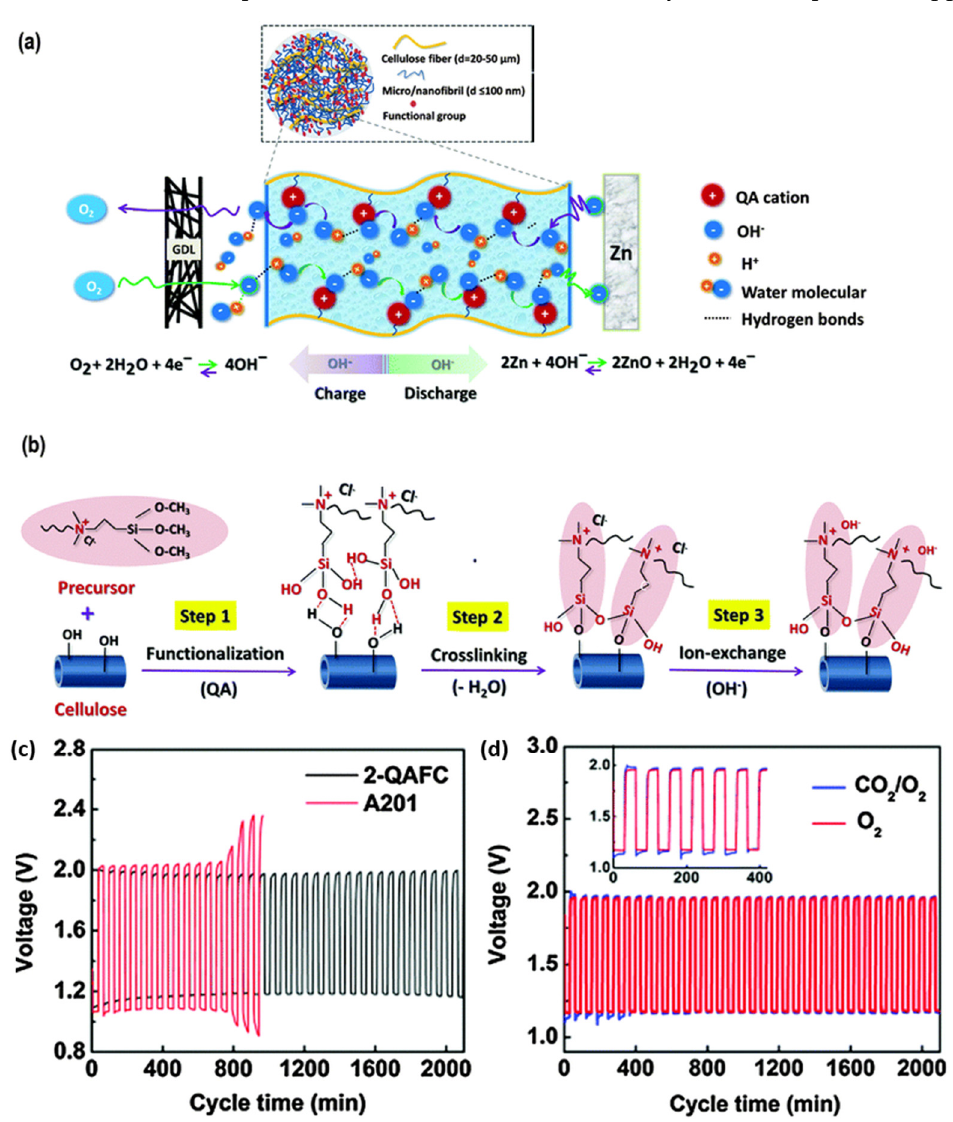
Figure 15. ( a ) Schematic representation of rechargeable zinc–air battery fabricated employing solid- state electrolyte QA − functionalized nanocellulose membrane layer. (gas diffusion layer (GDL); QA: quaternary ammonium) ( b ) Stepwise structural development of the cellulose nanofibre superficial layer including functionalization, cross-linking and hydroxide ion-exchange. ( c ) Charge/discharge cyclization of zinc–air batteries fabricated using 2 − QAFC and A201 membranes with 60 min each cycle time at 250 mA/g current density ( d ) Charge/discharge cyclic performance of the zinc–air battery in the presence of neat oxygen and 20,000 ppm CO 2 contaminated gas reactants, respectively, with 60 min each cycle time at a current density of 250 mA/g [75]. Reprinted with permission from Ref. [75], Copyright 2016, The Royal Society of Chemistry.